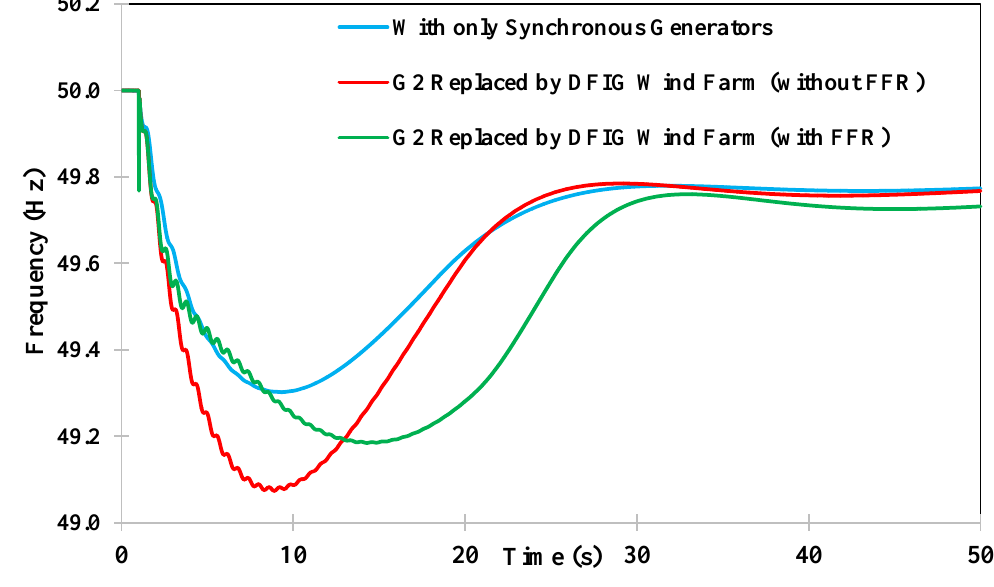
Figure 8. Frequency response with DFIG wind generation.